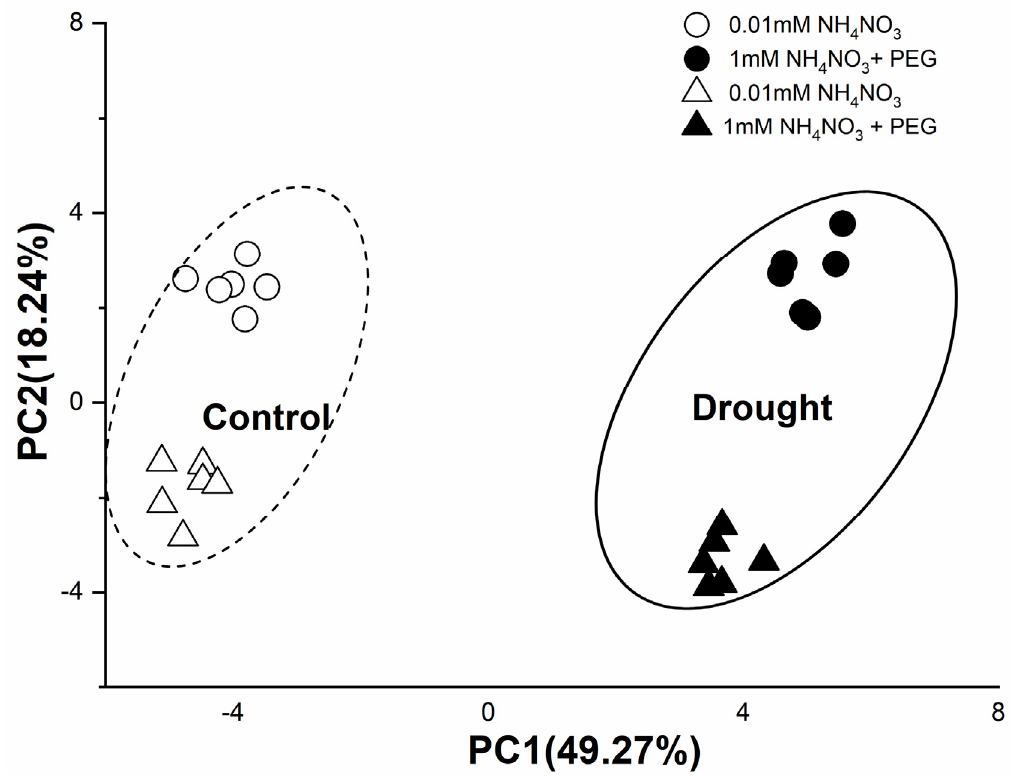
Figure 7. PCA plots of the first two principal components in roots and leaves of Populus simonii as affected by nitrogen supply and drought stress. PCA was conducted based on data (both values were averaged in the same treatment) of parameters presented in Supplementary Table S4.